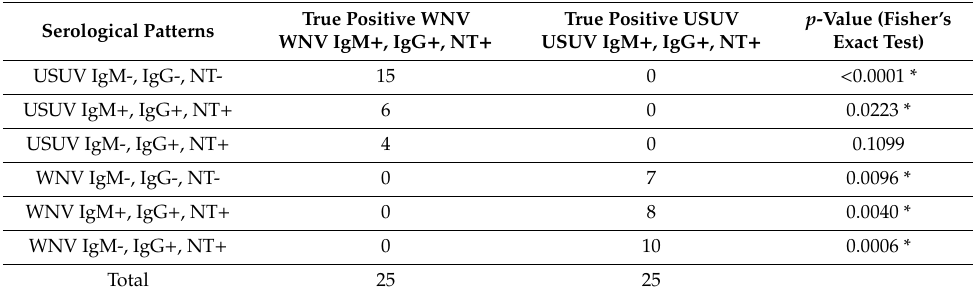
Table 2. Antibody patterns in 50 confirmed blood donors: comparison between true positive WNV- and true positive USUV-positive blood donors.